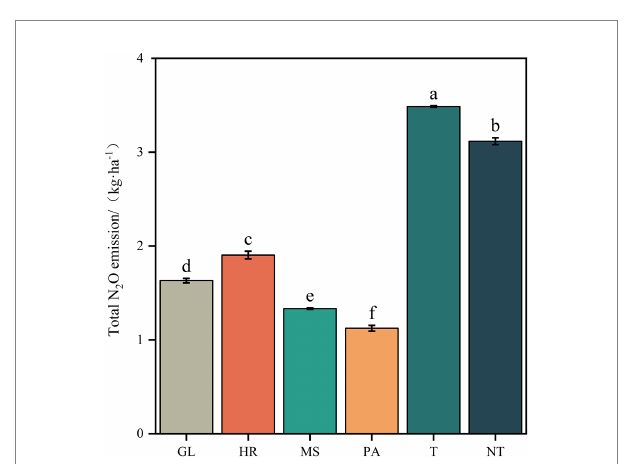
FIGURE 6 Response of cumulative N 2 O flux to different land use patterns on a semi-arid Dingxi. Vertical error bars represent the standard error of mean values. Different lower-case letters show significant differences between different treatments at p <